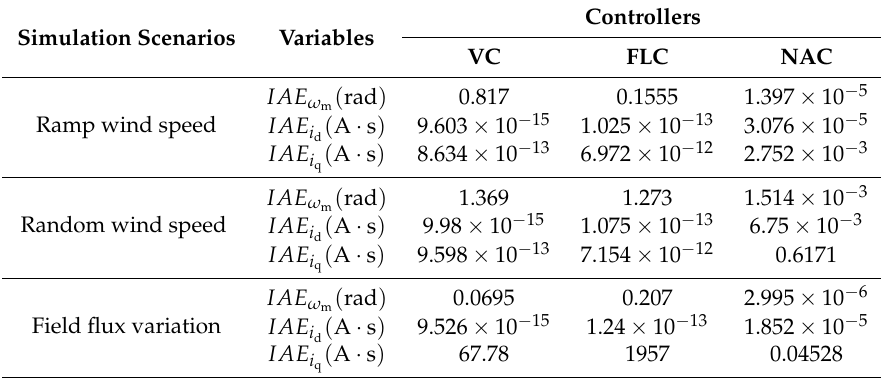
Table 3. IAE indices of different controllers in different